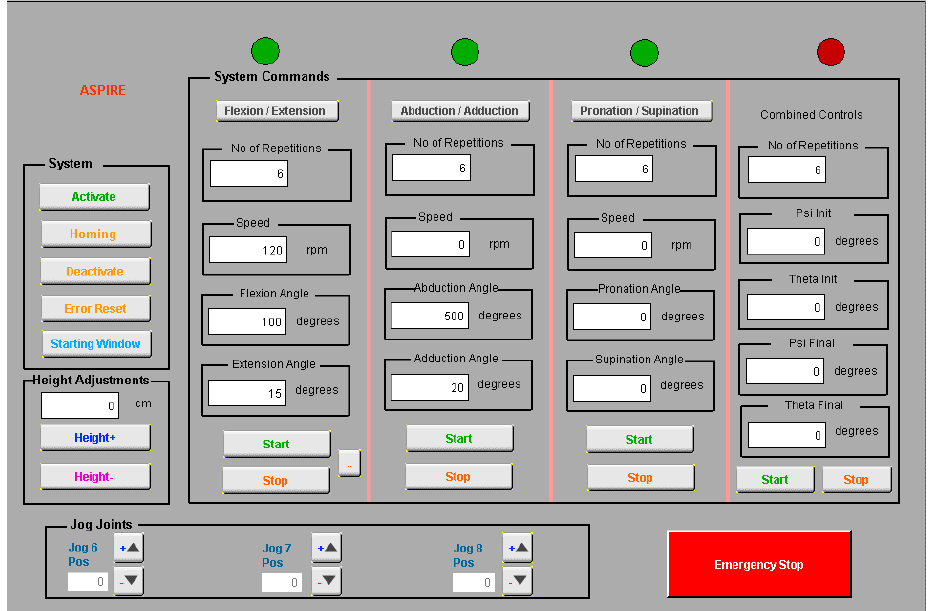
Figure 5. Graphical User Interface of ASPIRE.